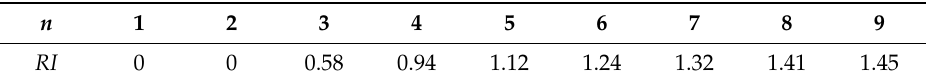
Table 2. Average random consistency indicator,